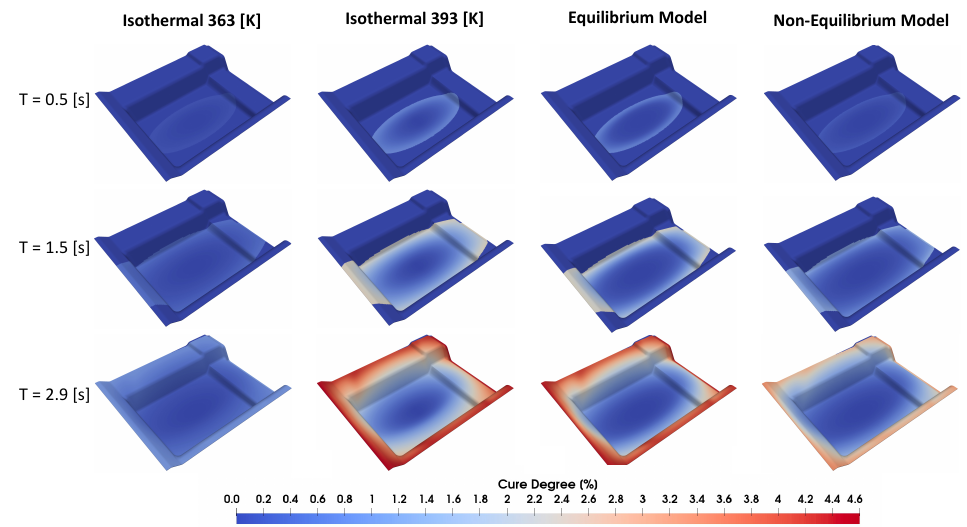
Figure 8. Predicted cure degree development during infiltration using different energy modelling